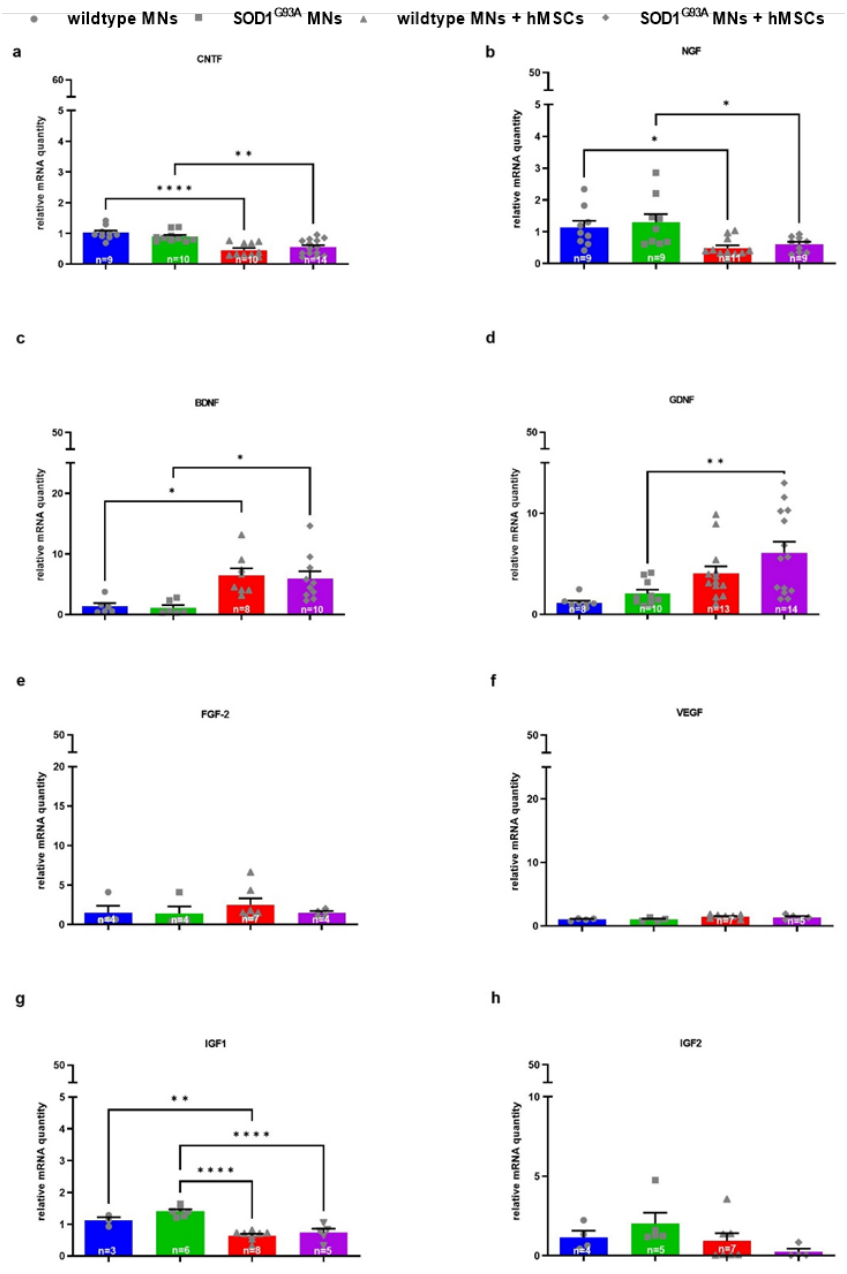
Figure 7. Altered mRNA levels of growth factors (CNTF, NGF, BDNF, GDNF and IGF-1) in MNs co-cultured with hMSCs. 10,000 wildtype or SOD1 G93A MN were seeded on 10,000 hMSCs. After 5 DIV cells were lysed and mRNA was isolated and transcribed to cDNA. Quantitative analysis was performed with HPRT1 (for CNTF, IGF1, IGF2, respectively), Act (for VEGF, BDNF, GDNF, respectively), PPIA (for FGF-2) and GAPDH (for NGF) as housekeeping genes and expression patterns were analysed by comparative Ct method (2 − ∆∆ Ct ). ( a ) CNTF mRNA levels ( n = 9–14). ( b ) NGF mRNA levels ( n = 9–11). ( c ) BDNF mRNA levels ( n = 6–10). ( d ) GDNF mRNA levels ( n = 8–14). ( e ) FGF-2 mRNA levels ( n = 4–7). ( f ) VEGF mRNA levels ( n = 4–7). ( g ) IGF1 mRNA levels ( n = 3–8). ( h ) IGF2 mRNA levels ( n = 4–7). Statistical analyses were performed with ordinary one-way ANOVA and Tukey’s multiple comparisons post-hoc test: * p < 0.05, ** p < 0.01 and **** p < 0.0001. Single values are represented as repeated measurements together with mean ± SEM. Statistic analysis between monocultures and co-cultures of different genotypes are not